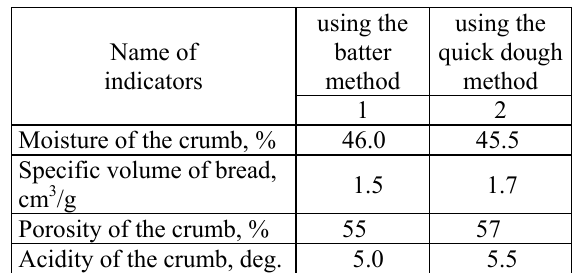
Table 6 . Quality indicators of bread with dry